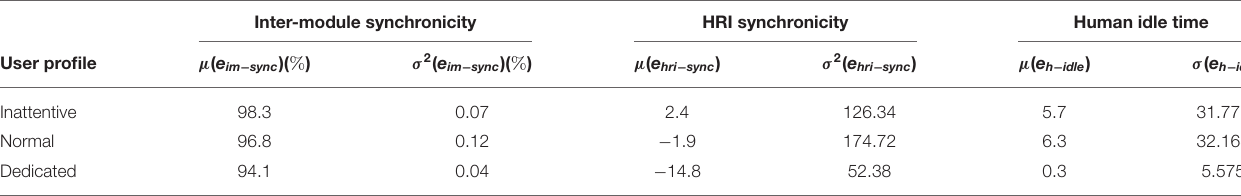
TABLE 5 | Performance metrics